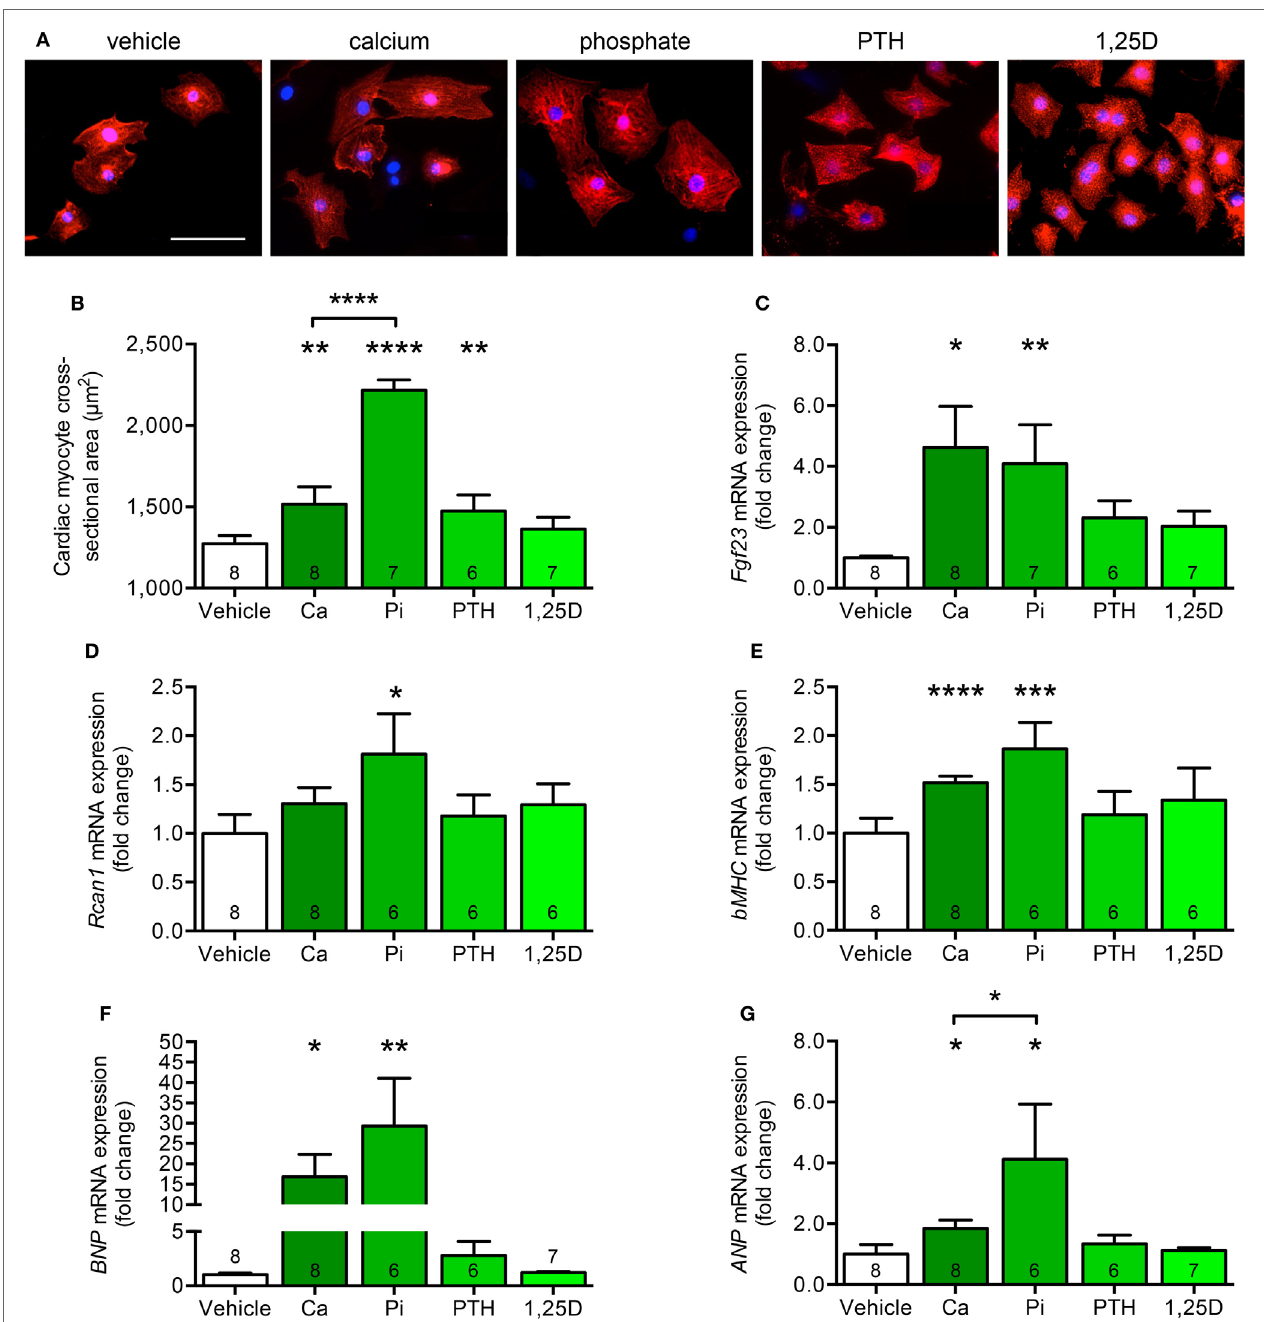
FigUre 7 | Calcium and phosphate treatment induces cell growth and pro-hypertrophic gene expression in cultured neonatal rat ventricular myocytes (NRVM). (a,b) Immunofluorescence staining for sarcomeric α -actinin followed by quantification demonstrates enhanced cardiac myocyte cross-sectional area after treatment of NRVM with calcium, phosphate, and PTH, but not 1,25D (magnification, 40 × ; scale bar, 50 µm). (c) Calcium and phosphate stimulation significantly increases Fgf23 mRNA expression in NRVM. (D) Rcan1 mRNA levels are significantly enhanced by treatment of NRVM with phosphate. The mRNA levels of (e) bMHC , (F) BNP , and (g) ANP are significantly upregulated after stimulation of NRVM with calcium and phosphate. Values are presented as mean ± SEM; numbers in each bar graph represent the n- values used for the respective measurement; * P < 0.05, ** P < 0.01, *** P < 0.001, **** P < 0.0001. Abbreviations: Ca, calcium; Pi, phosphate; PTH, parathyroid hormone; 1,25D, 1,25(OH) 2 D 3